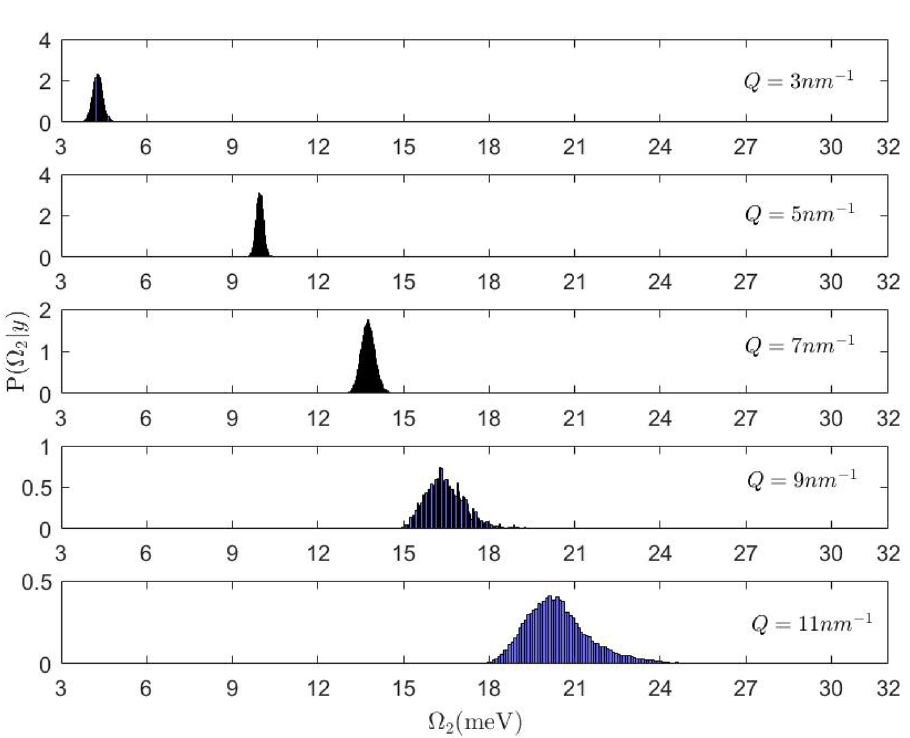
Figure 5. Posterior distribution of the frequency of the longitudinal acoustic mode in pure water, given the available data y , at different values of the momentum transfer Q